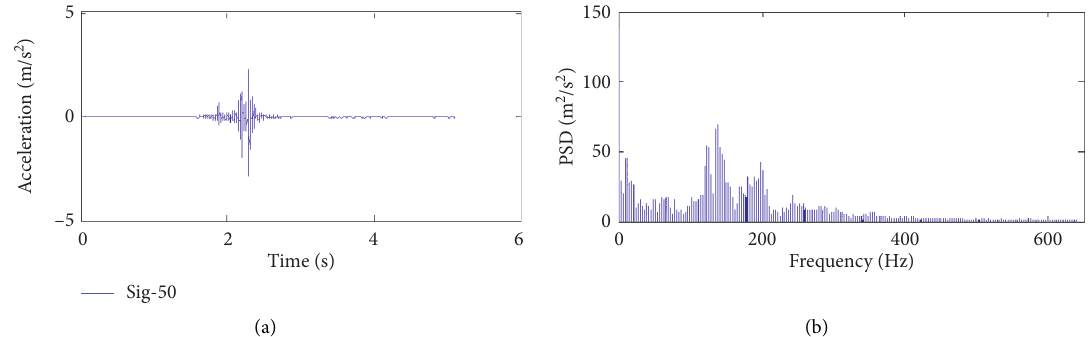
Figure 8: 50cm measuring point signal and power spectral density curve: (a) original signal at 50cm, and (b) power spectrum curve of 50cm